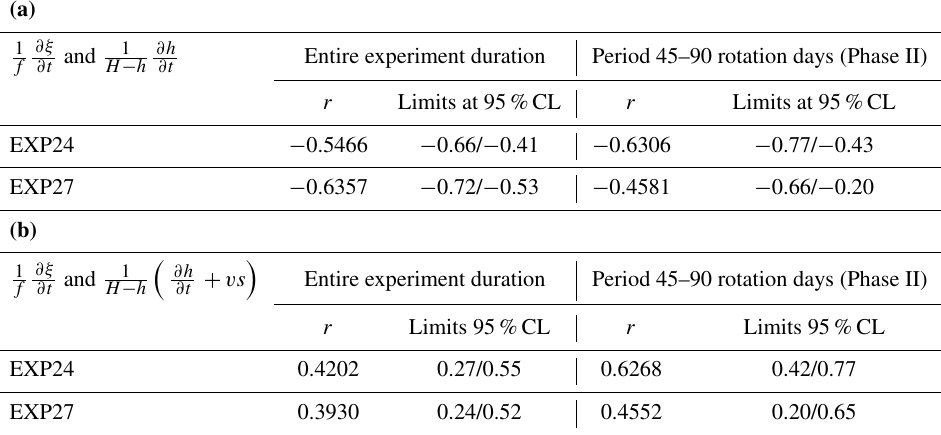
Table 3. (a) Correlation coefficients ( r ) between the terms of the vorticity equation (Eq. 1) for the central deep part of the tank. (b) Correlation coefficients ( r) between the terms of the vorticity equation (Eq. 1) for the slope of the tank. Upper and lower limits of the coefficients are given at the 95% confidence level (CL) for both (a) and (b)